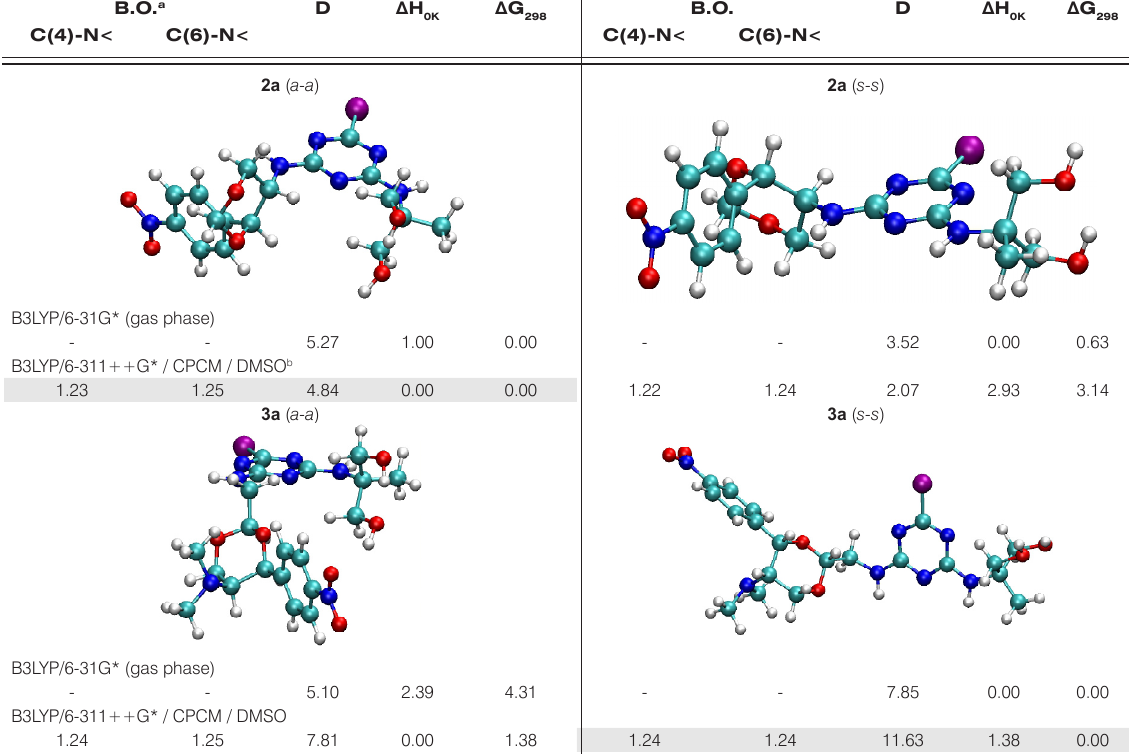
(kJ mol -1 ) and relative free energies Δ G 0K